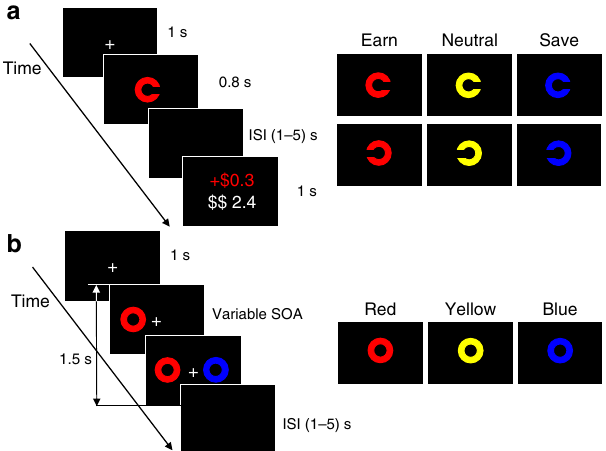
Fig. 1 Illustration of the display sequences and target stimuli examples. a Monetary reinforcement task. Exp. 1a involved a color discrimination (red, blue, and yellow), while Exp. 1b and 1c involved a gap side (left and right) discrimination. After response, participants were informed about gain or loss, together with the total cash bonus accrued (in white). b Temporal- order judgment task. Following fi xation, colored circles were presented either on the left or on the right side of the fi xation followed by a second different color circle, which appeared on the opposite side after a variable SOA (8, 18, 38, 68, and 98 ms). Participants were required to indicate which color (Exp 1a) or which side (Exp 1b and 1c) appeared fi rst